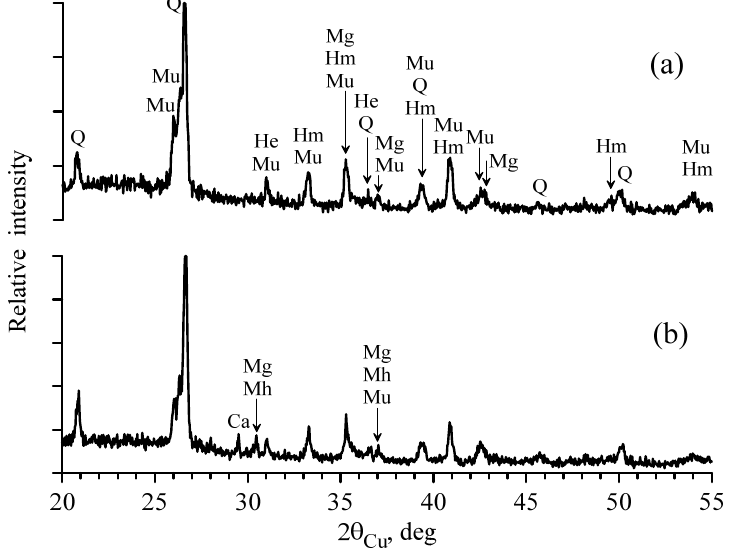
Figure 5. XRD patterns of the fly ashes samples FA1 ( a ) and FA2 ( b ).